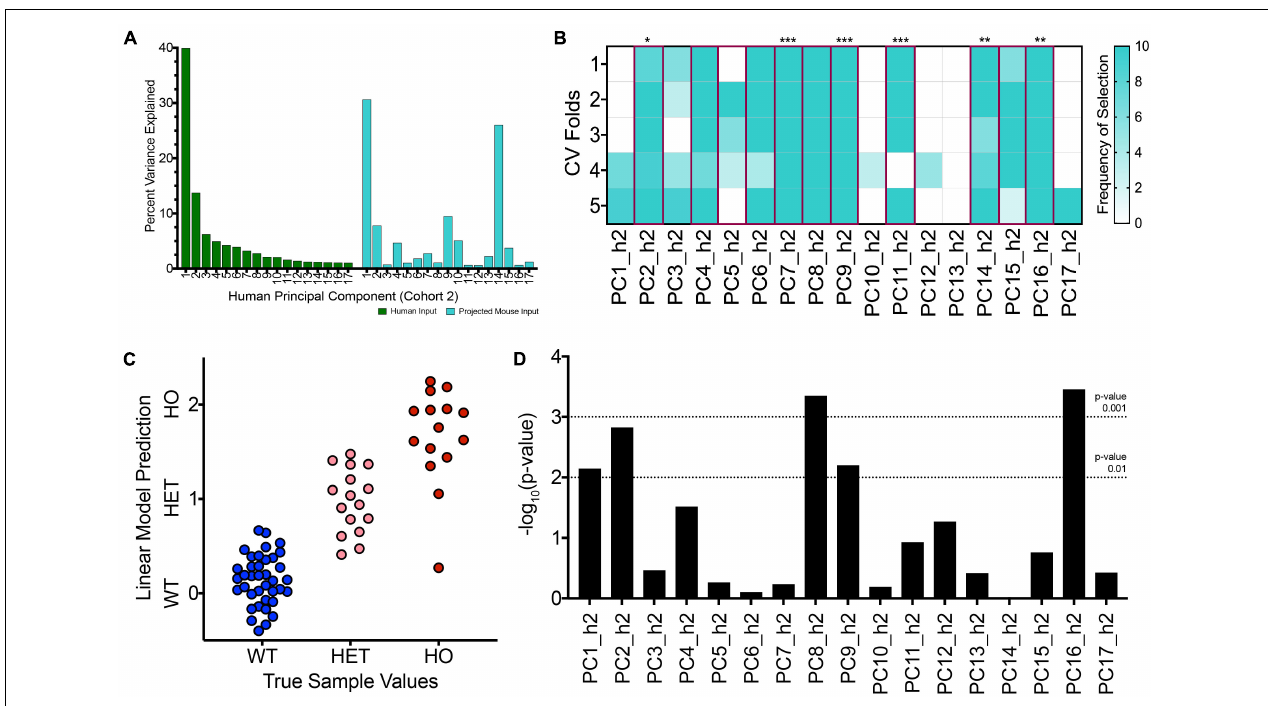
FIGURE 5 | With a second, independent human cohort, TransComp-R modeling successfully identifies translatable, human principal components that are important for TASTPM mouse sample outcomes. (A) Percent variance explained by each human PC for the original human dataset used to generate the PCA model (GSE1297, cohort 2; green) and the projected TASTPM mouse dataset (turquoise). (B) Frequency of human PC (PC_h2) selection across ten rounds of 5-fold cross validation using LASSO feature selection. PCs selected at the selection frequency threshold of 40 percent are highlighted in magenta with the significance of the linear model coefficient weight provided (* < 0.05, ** < 0.01, *** < 0.001). (C) Visualizing the linear model predictions on a mouse sample-by-sample basis from the final translatable model across the wild type (WT), heterozygous TASTPM (HET), and homozygous TASTPM (HO) groups. (D) Results from linear modeling evaluating which PCs contain information that is relevant for disease-status, in addition to the information encoded by sample